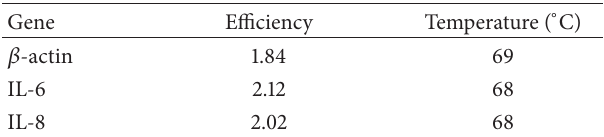
Table 2: Primer efficiencies and corresponding annealing tempera- tures for 𝛽 -actin, IL-6, and